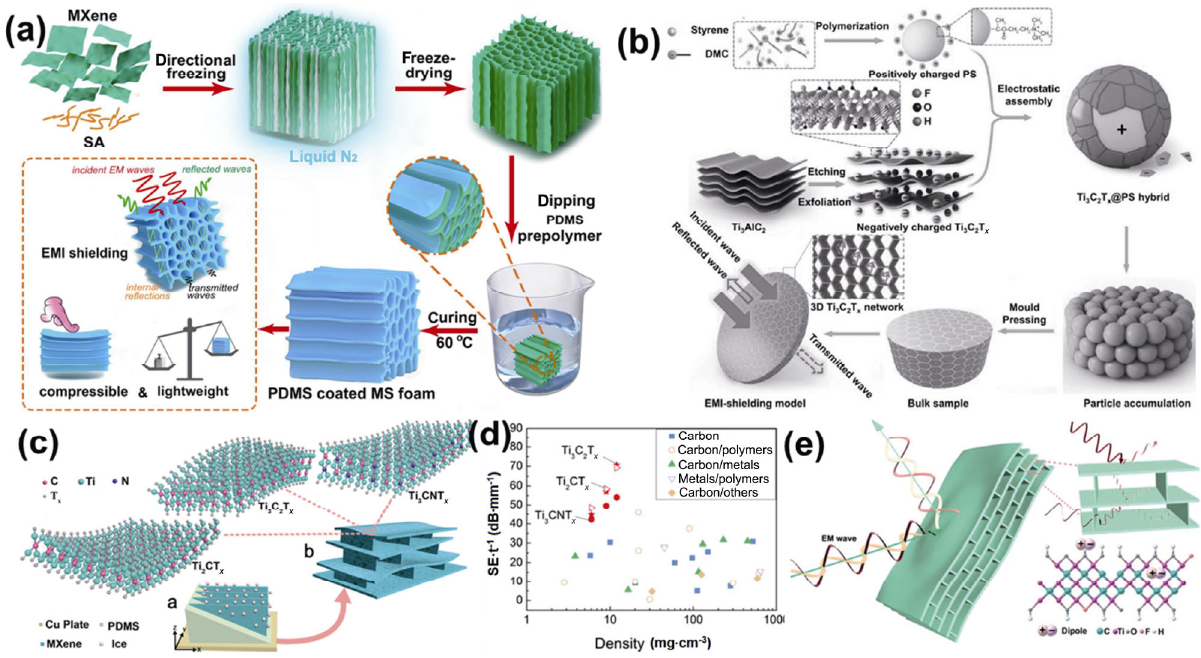
Fig. 31 Preparation process: (a) MS hybrid aerogel and its PDMS-coated MS foam. Reproduced with permission from Ref. [257], © Elsevier B.V. 2020. (b) Ti 3 C 2 T x @PS nanocomposites. Reproduced with permission from Ref. [258], ©